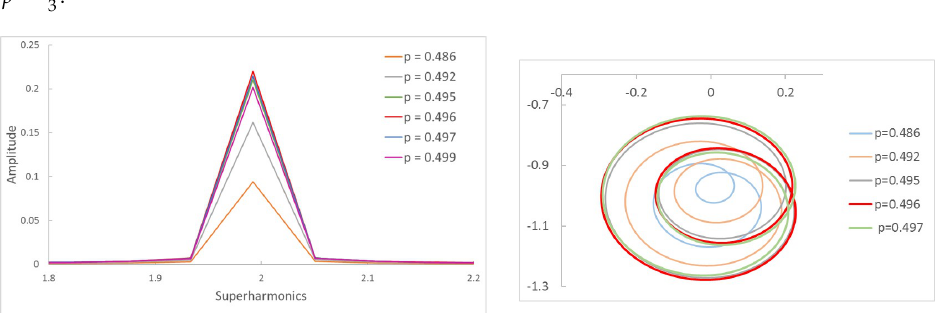
Figure 13. FFT of the transversal displacement and orbits for α = 0.2 and a speed interval close to p = 1 2